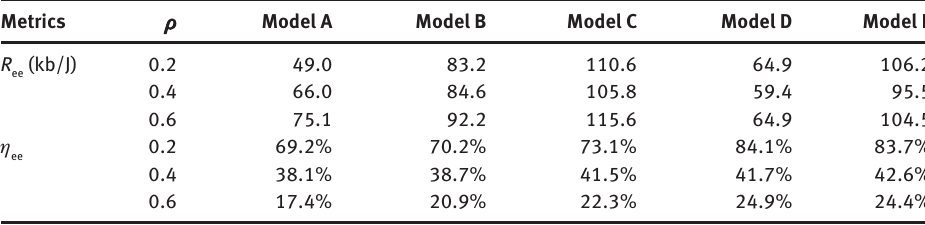
Table 5. Energy Efficiency of the APSM in Different Power Consumption Models Under the EXP Traffic, c = 3. Metrics